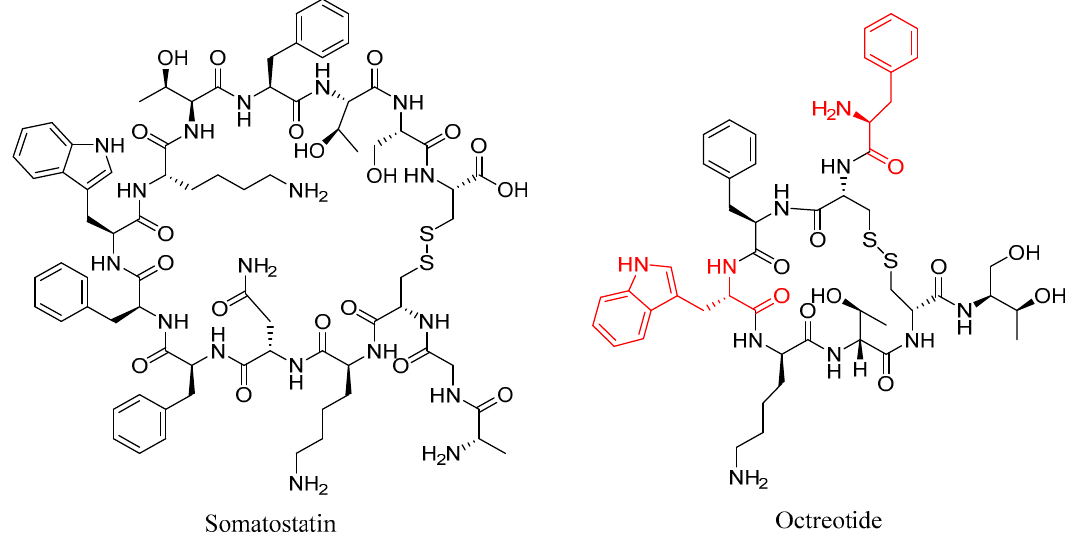
Figure 7. Structures of somatostatin and octreotide, with the D-amino acid modifications on octreotide highlighted in red.